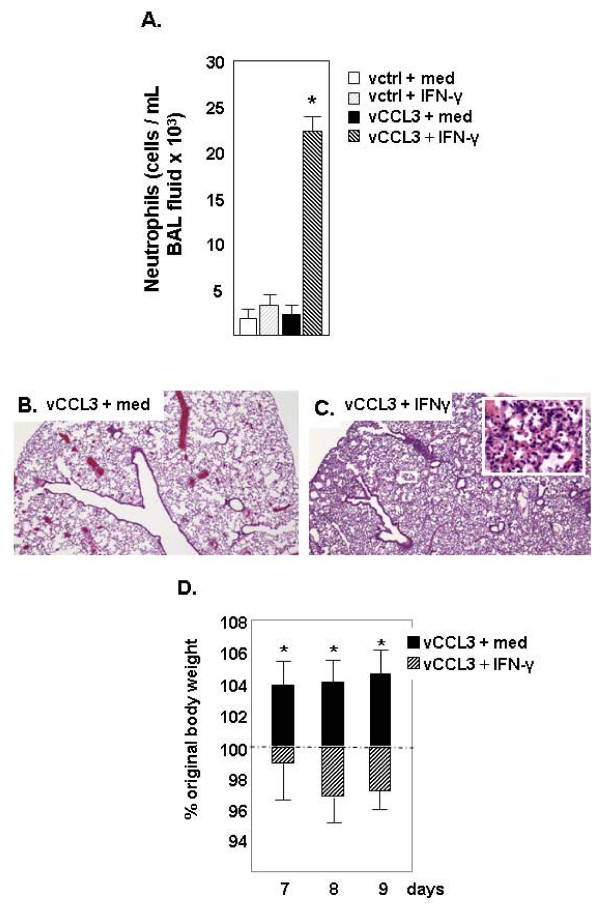
Neutrophil recruitment in response to CCL3 is ablated in IFN-γ gene-deleted mice. (A) Neutrophils detected in BAL fluid of IFNγ gene-deleted (IFNγ -/-) mice (+vctrl +med (medium; RPMI + 10% FCS vehicle control); open bar), + IFNγ (+vctrl + IFNγ, grey-shaded bar), +vCCL3 +med (black bar), or +vCCL3 + IFNγ (black-shaded bar); *p < 0.01 vs. other conditions, day 9 after challenge with vCCL3 or vctrl. (B, C) Microscopic images of lung tissue from IFN-γ -/- mice challenged with (B) vCCL3 + med or (C) vCCL3 + IFNγ; original magnification, 20×. Inset, original magnification 63×, documenting neutrophil recruitment. (D) Change in body weight in response to CCL3 overexpression ± IFN-γ; *p < 0.01 at time points shown.